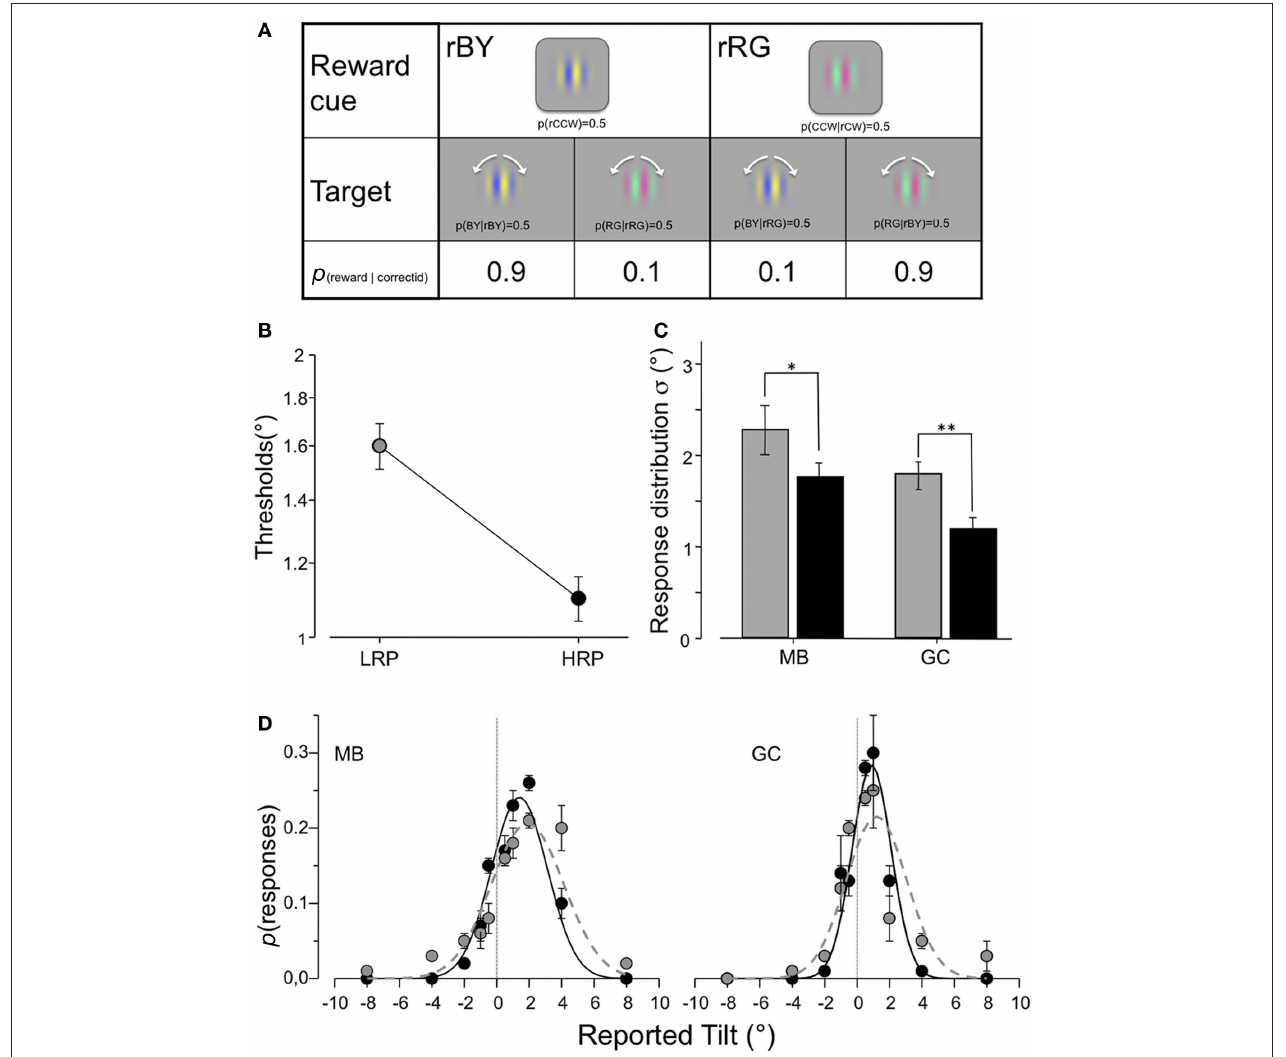
the main experiment and the model, decreasing by a factor of about 1.5 when the color of the cue and the target gratings matched ( p < 0.001). (C,D) The behavioral tuning functions obtained by two observers (MB and GC) by collapsing the two near-threshold tilts (1 ° and 2 ° ) confirm the results of the previous experiments showing narrower σ and more veridical μ in the HRP condition. Error bars and reliability of the effects are based on a bootstrap procedure (see Materials and